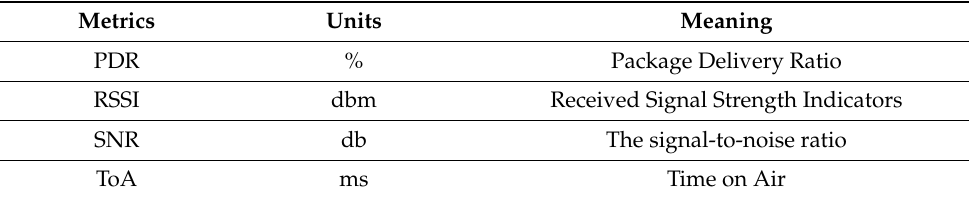
Table 4. Summary of evaluated metrics.